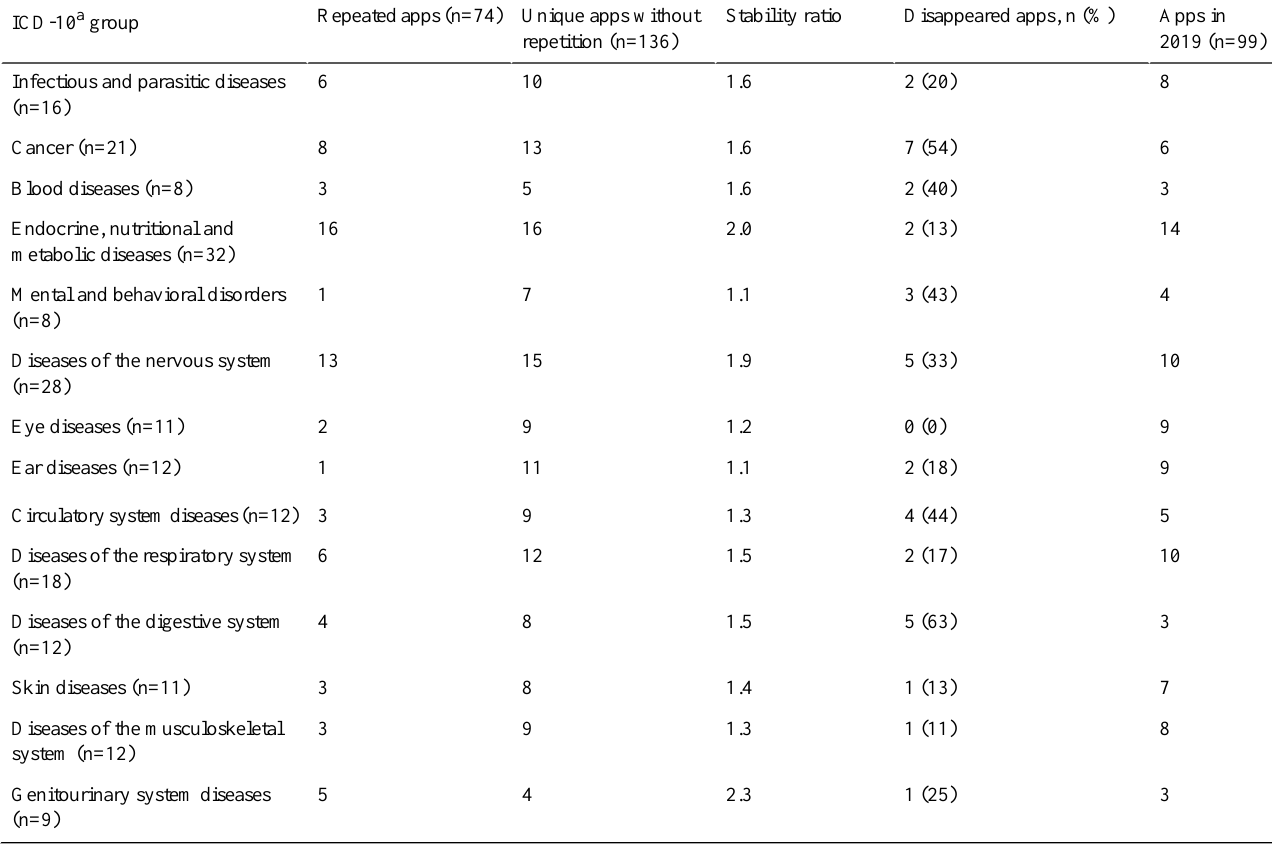
Table 5. Stability of the results through the years by group of disease (n=210).